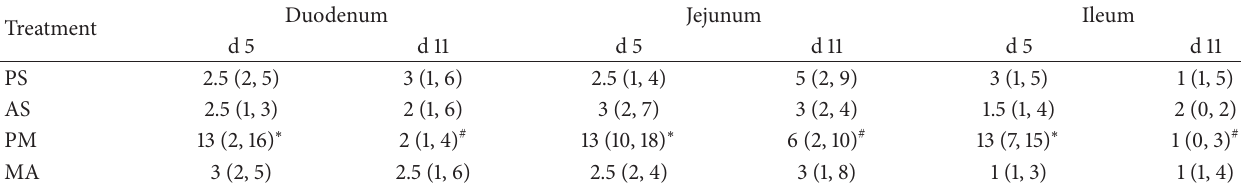
Table 2: Histological severity scores for C57BL/6 mice ( 𝑛 = 8 /group) treated with PS, PM, AS, and MA. Treatment